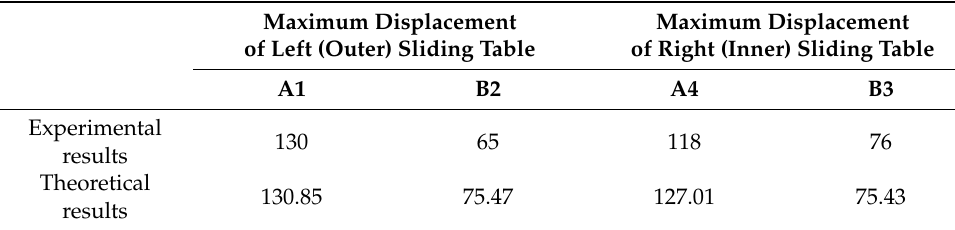
Table 5. Experimental results and calculation results of sliding table displacement (mm).